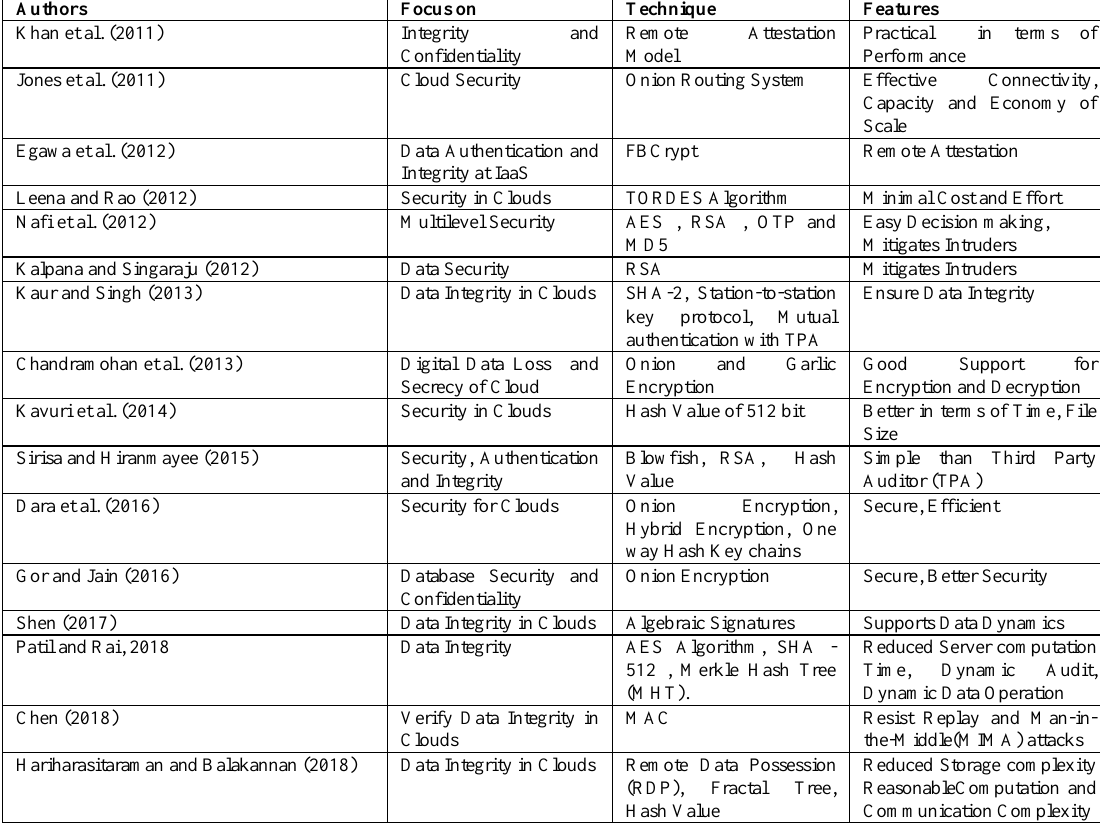
Table 1. Works related to data security and